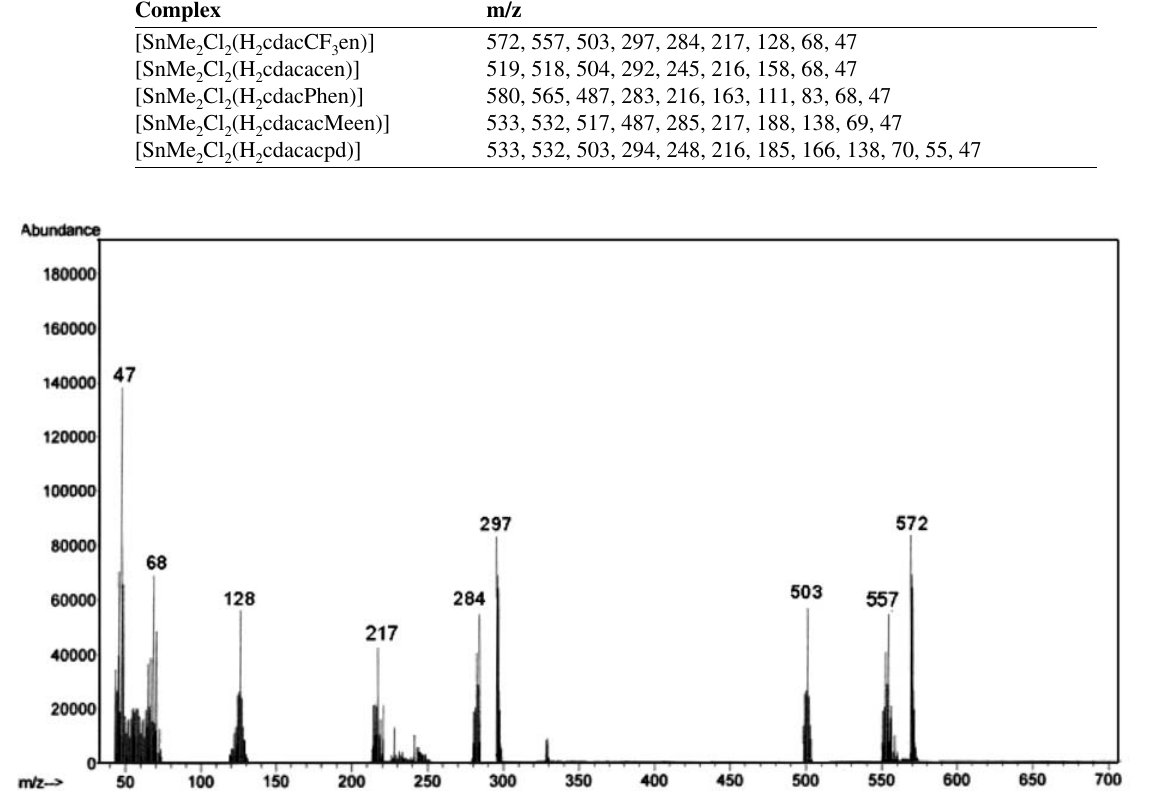
Figure 2. The mass spectrum of the [ SnMe